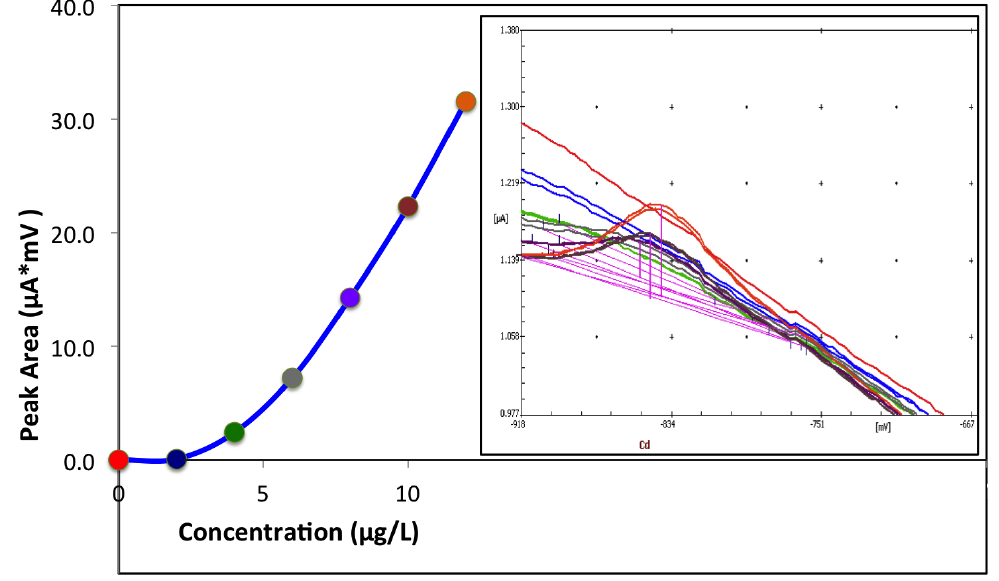
Figure 2. Non-linear calibration curve of cadmium analysis, and the corresponding ASV curves, at low concentrations (2 µ g/L each addition) with a Type-B BiFE.